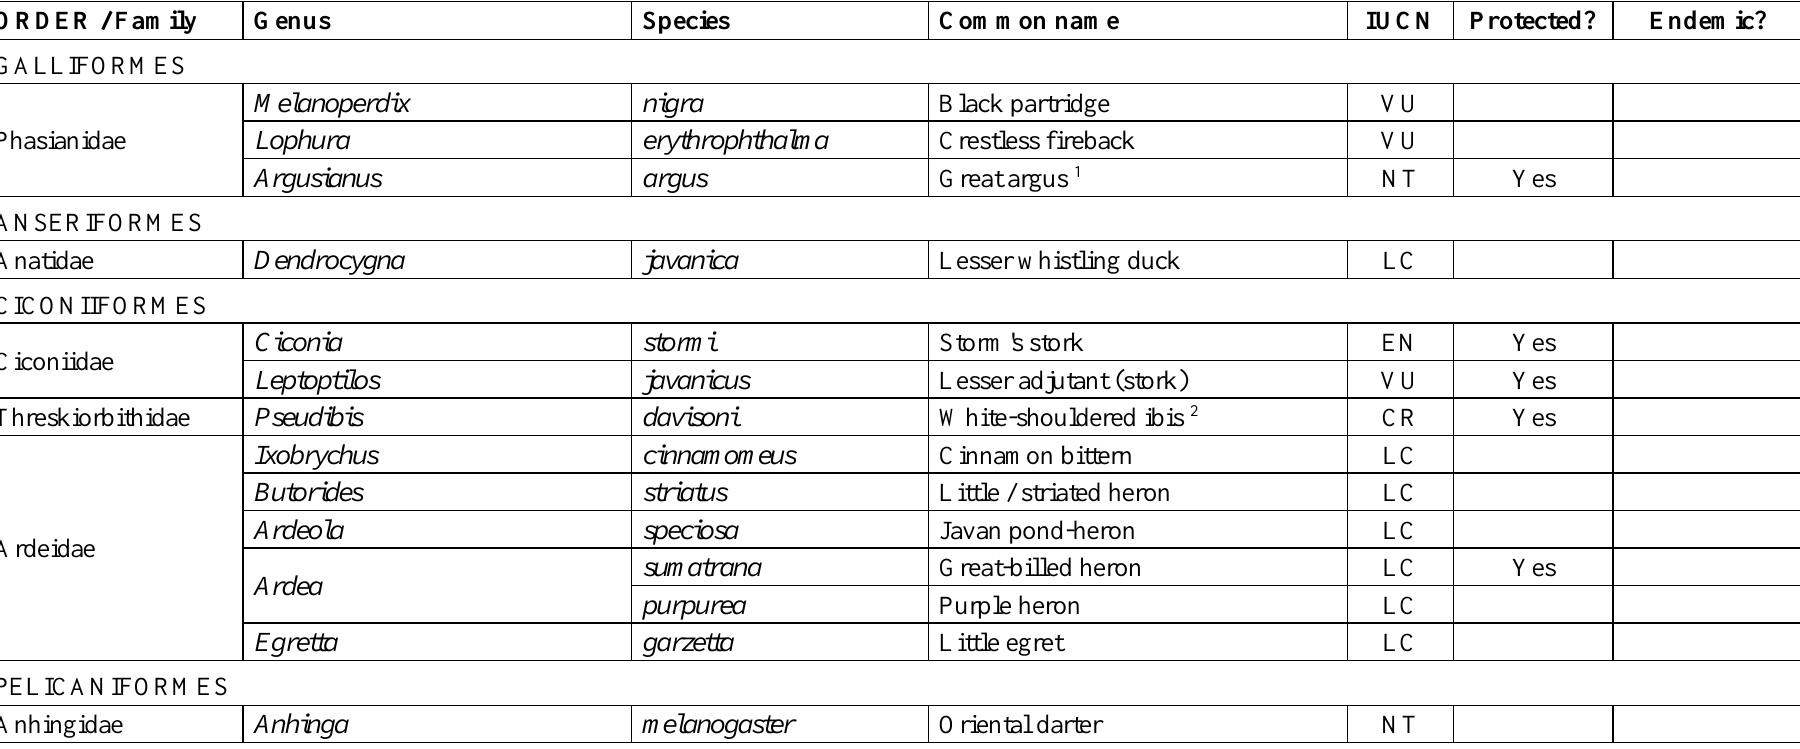
Table A9. List of bird (Aves) species recorded in the NLPSF, Sebangau, together with IUCN Red List classifications (CR = critically endangered; DD = data deficient; EN = endangered; LC = least concern; NT = near threatened; VU = vulnerable), Indonesian protected species listings (‘Protected?’ refers to protection status in Indonesia) and Borneo endemic species assignments. Parentheses for Latin names indicate synonyms and slashes indicate cases where identification between two options is uncertain. For English names, parentheses indicate optional parts of the name and slashes indicate alternative